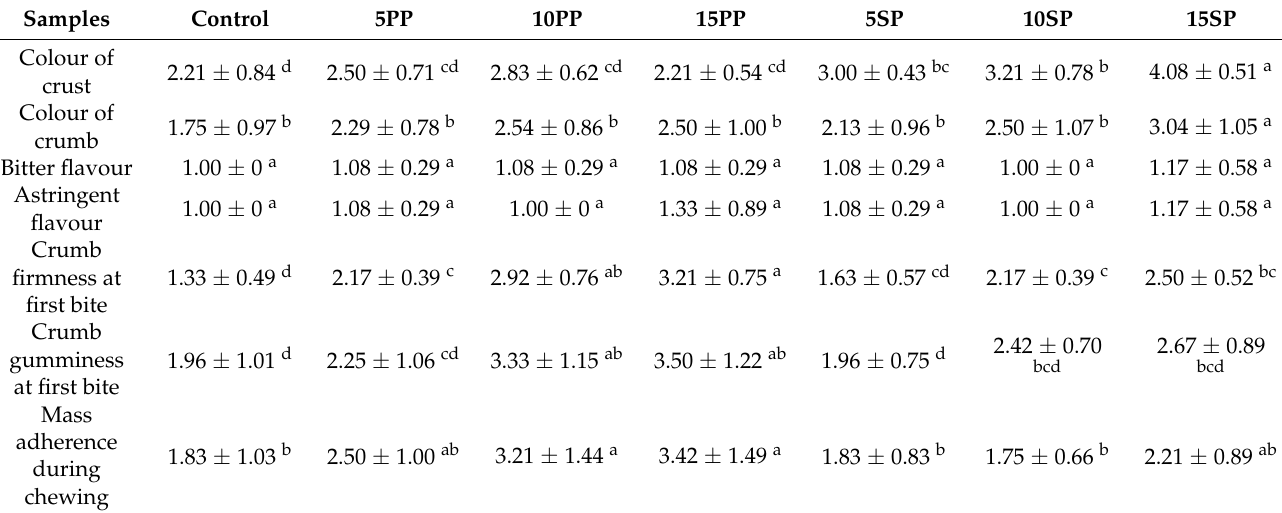
Table 5. Sensory profile of bread samples using a descriptive